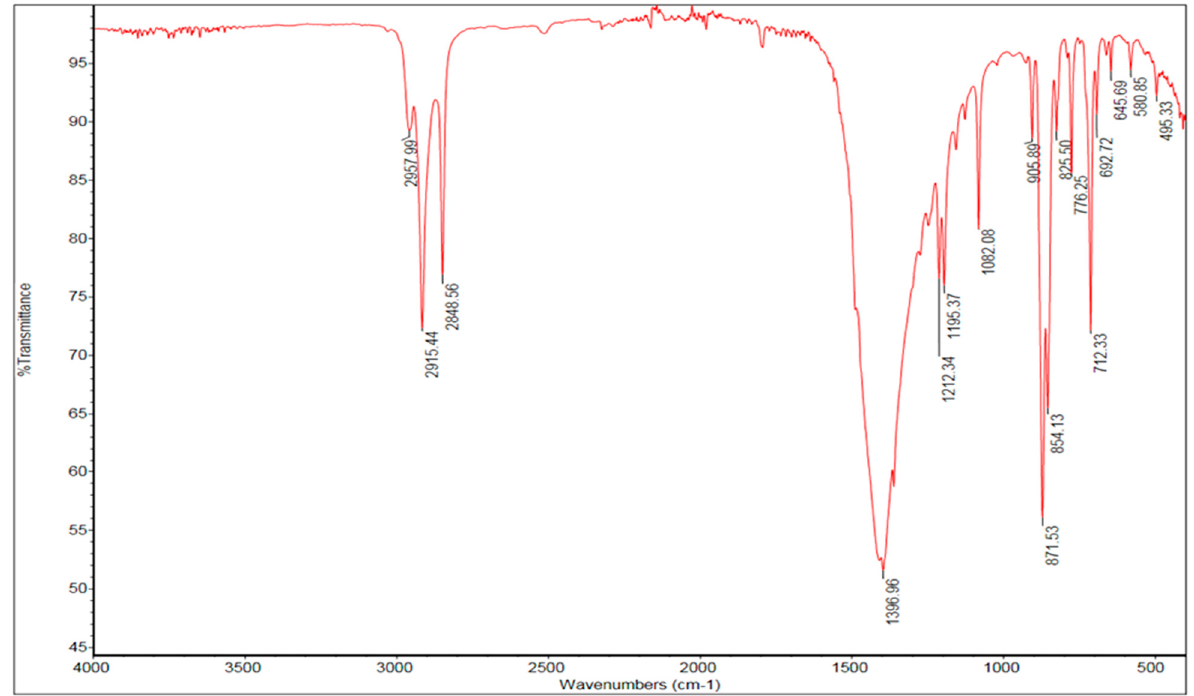
Figure 7. FTIR analysis of pro-oxidant (d2w grade).